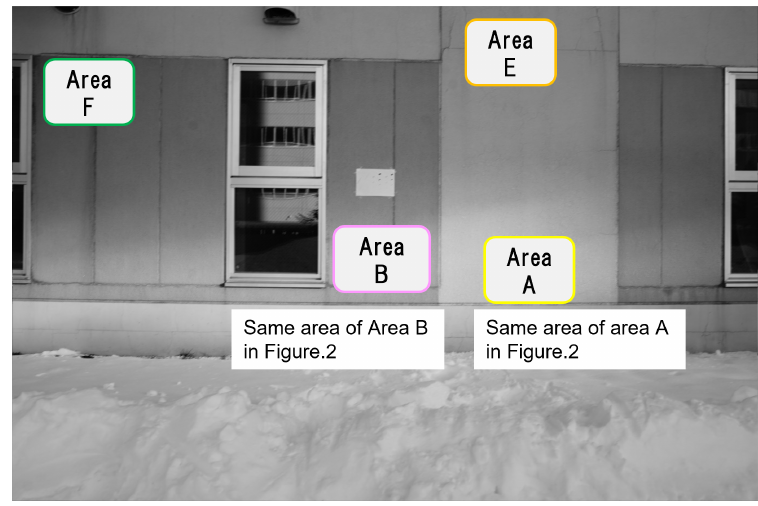
Figure 10. Areas with uniform and simple shapes as feature points captured by a fixed camera.